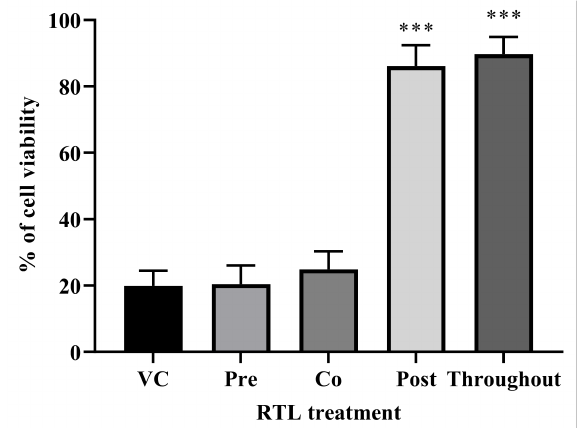
Figure 7. Effect of time of addition of RTL (2xEC50 dose) on ZIKV-induced death of hNSCs. Cells were treated with RTL (2xEC50 dose) at pre-, co-, post- and throughout-treatment time frame of ZIKV infection. Each bar represents differences between six individual wells of a two-independent experiment. *** p < 0.001 by one-way ANOVA using Dunnett’s multiple comparison